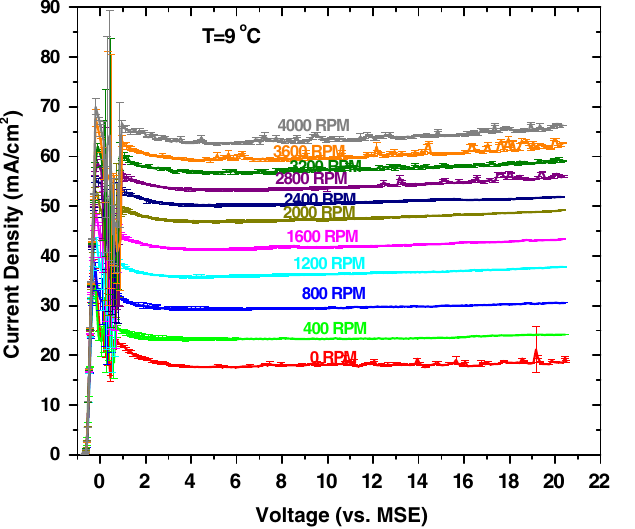
FIG. 3. (Color) The anode polarization curves of Nb RDE in 1:10 volume ratio HF and H